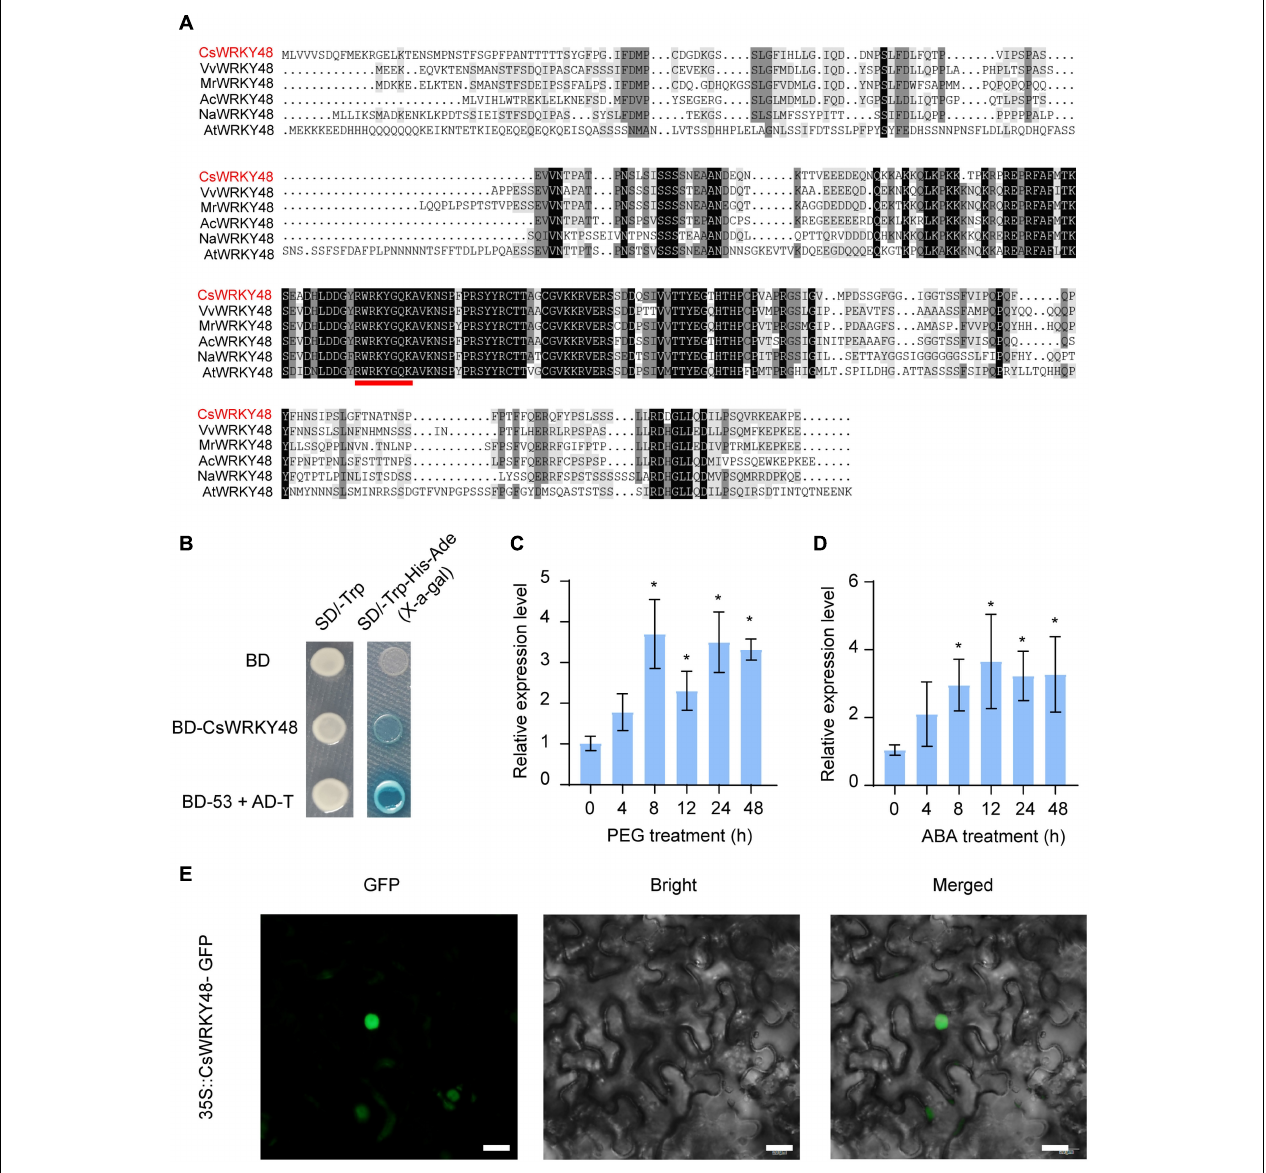
FIGURE 5 | CsWRKY48 acts as a transcriptional activator and is expressed in response to drought and ABA treatment. (A) Multiple sequence alignment of CsWRKY48 and its homologs in other plant species. The red line indicates the WRKY DNA-binding domain. (B) Transactivation analysis of CsWRKY48 in yeast. (C) Transcript levels of CsWRKY48 under PEG treatment. (D) Transcript levels of CsWRKY48 under ABA treatment. (E) Subcellular localization of 35S::CsWRKY48-GFP in tobacco cells. Bar = 20 µ m. The data are presented as the means ± SDs of three independent experiments. Significant differences were determined using Student’s t -test (* P <